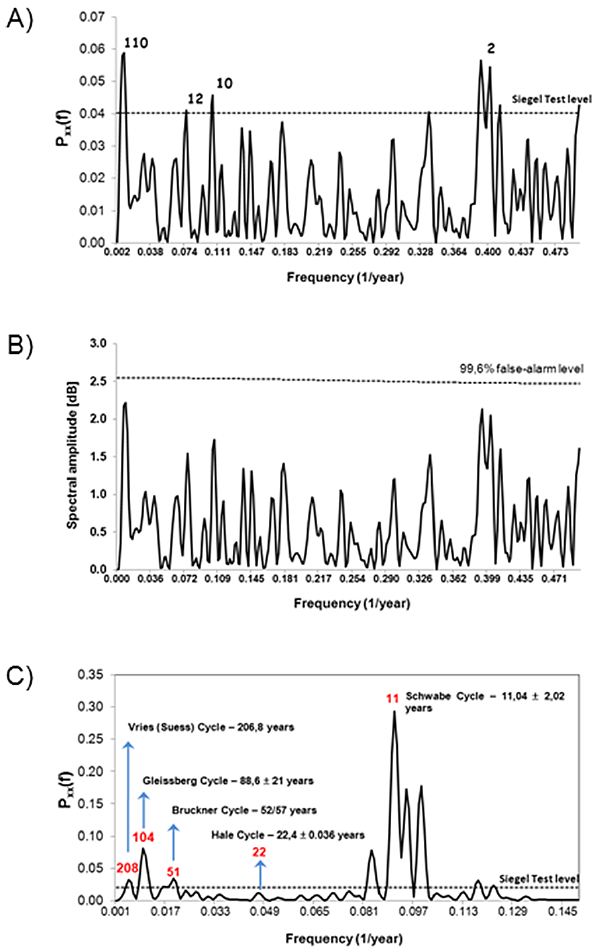
Figure 4. (a) Harmonic analysis for the summer flood damage index INU. The dotted line represents critical level for the Siegel test and significant frequencies are shown in years. (b) Red noise AR1 spec- tra of INU. The dotted line shows false-alarm level. (c) Harmonic analysis for the average annual number of sunspots. The dotted hor- izontal lines represent critical levels for the Siegel test. Significant frequencies are shown in years. The principal solar cycles are high- lighted.